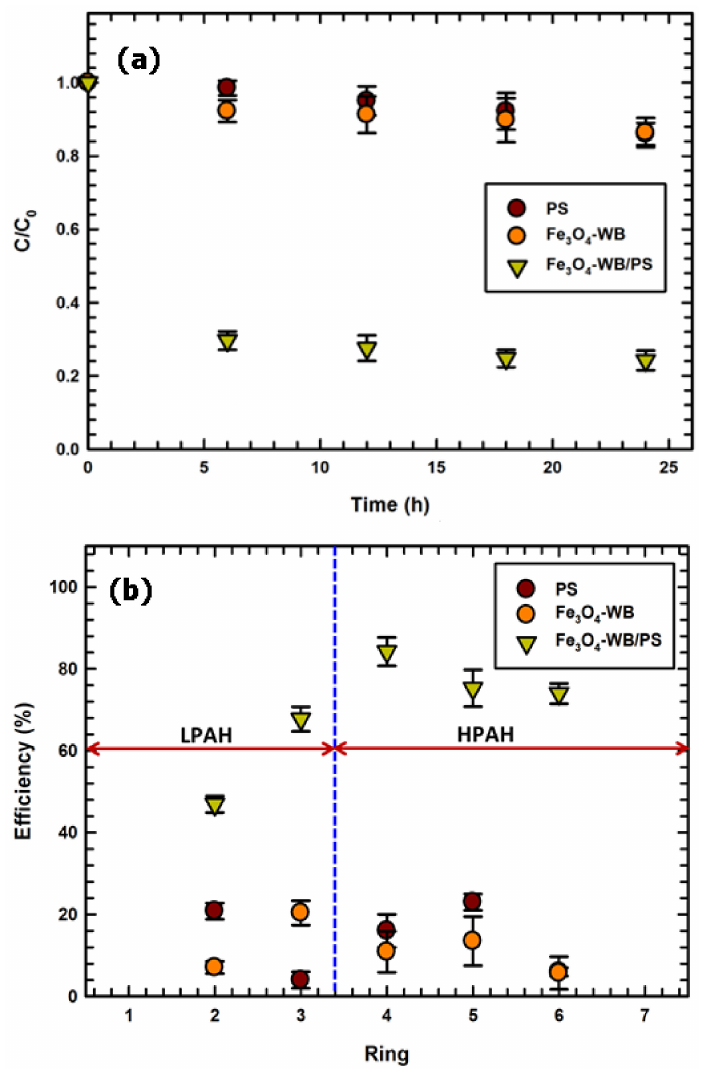
Figure 4. ( a ) Plots of decrease in polycyclic aromatic hydrocarbons (PAH) concentration (C/C 0 ) versus time and ( b ) efficiency of PAH degradation as function of ring number during different processes. Experimental conditions: amount of sediment = 1.00 g, reaction volume = 40 mL, T = 303 K, pH 0 = 6.0, [Na 2 S 2 O 8 ] = 2 × 10 − 5 M, [Fe 3 O 4 –WB] = 3.33 g/L, and molar ratio of PS: ∑ PAHs = 1:1. LPAH: